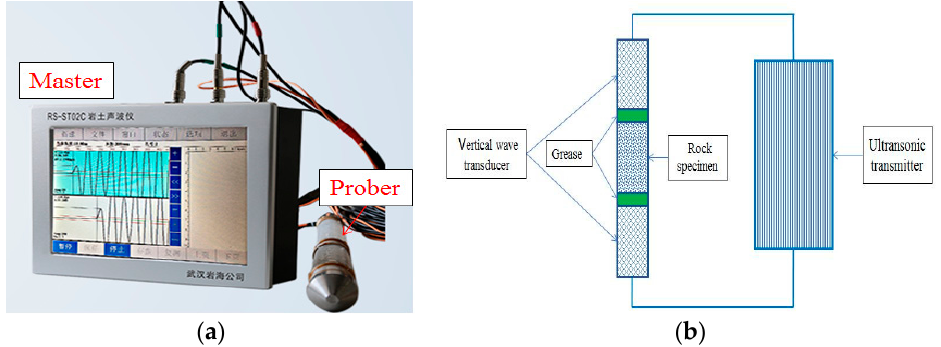
Figure 1. Measuring instrument and schematic diagram of RS-ST02C: ( a ) RS-ST02C non-metallic ultrasonic instrument; ( b ) Schematic diagram of the RS-ST02C measurement.